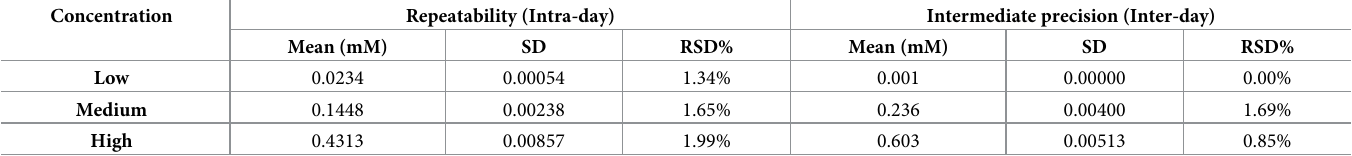
Table 3. Results of precision for the proposed method to determine Neu5Ac level.